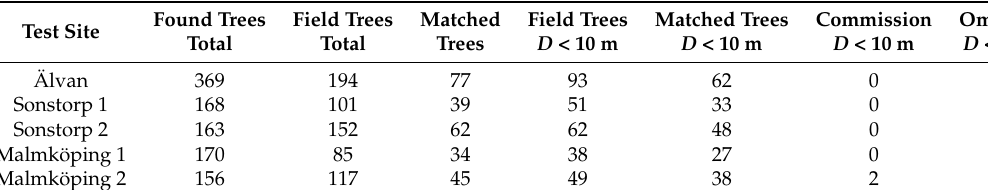
Table 5. Number of found trees, number of field trees, number of trees matched to field data, number of field trees within 10 m, number of matched trees within 10 m and commission and omission errors within 10 m. Results are based on the complete method using the intensity criterion for clustering.